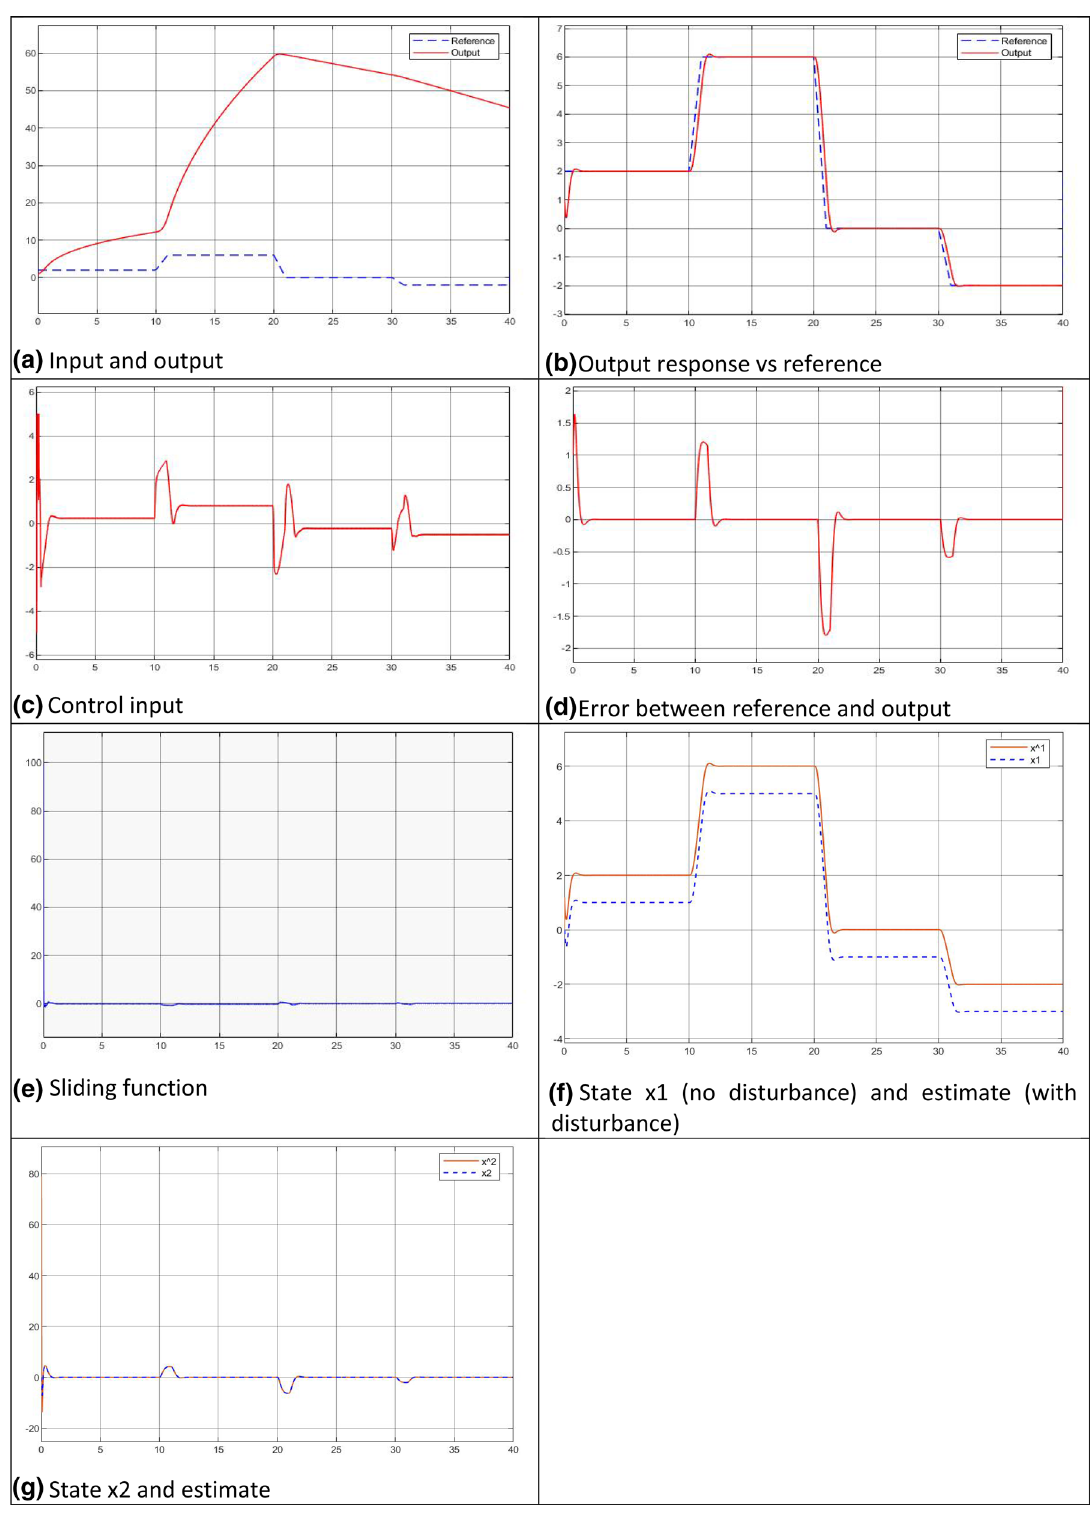
Figure 6. Case 1—simulated